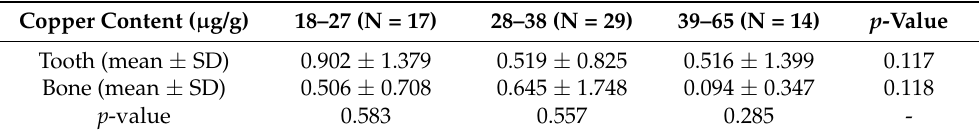
Table 23. Copper content in tested samples taken from patients of different age.